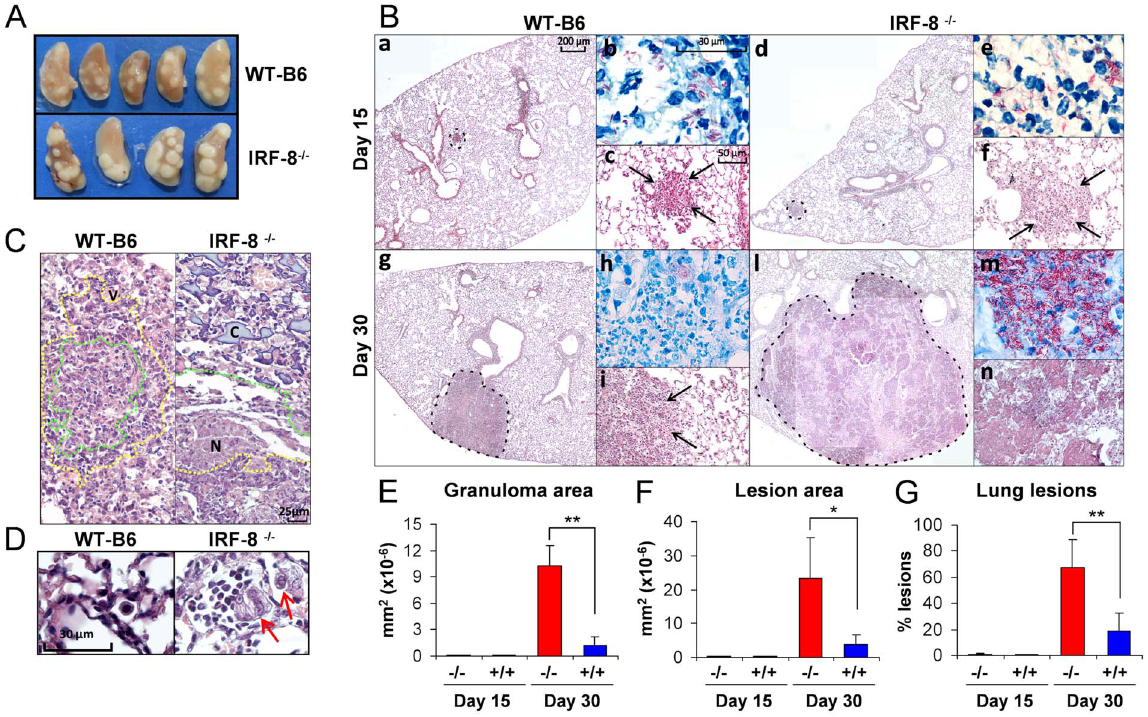
Figure 2. Uncontrolled growth of pulmonary granulomas at late phase of Mtb infection in IRF-8 2 / 2 mice. A) Macroscopic appearance of pathology of lungs in IRF-8 2 / 2 and WT-B6 mice at day 30 p.i. B) Histopathological analysis of lung sections colored with H&E at days 15 and 30 p.i.. Dotted lines in panels a, d, g, l (20X magnification) show granuloma formation. Panels c, f, i, n show a 200X magnification of the granuloma. Arrows depict granulomatous structures. Panels b, e, h, m (1000X magnification) show Ziehl-Neelsen acid-fast staining. C) Detail of granulomatous lesions at day 30 p.i. showing lymphocyte area (dotted yellow lines) and macrophage area (dotted green lines). V: blood vessel; N: coagulative necrosis; C: colliquative necrosis (400X magnification). D) H&E stained detail of macrophage area in granulomas (1000X) at day 30 p.i. showing foamy cells (red arrow). E–G) Extent of tissue damage assessed by E) median granuloma surface area; F) median total tissue surface area with lesions and G) percentage of tissue surface area with lesions with respect to total lung area. Five lungs per group were analyzed with at least three sections in two different points of the sample. Representative slides are shown. * P , 0.05; ** P , 0.01.